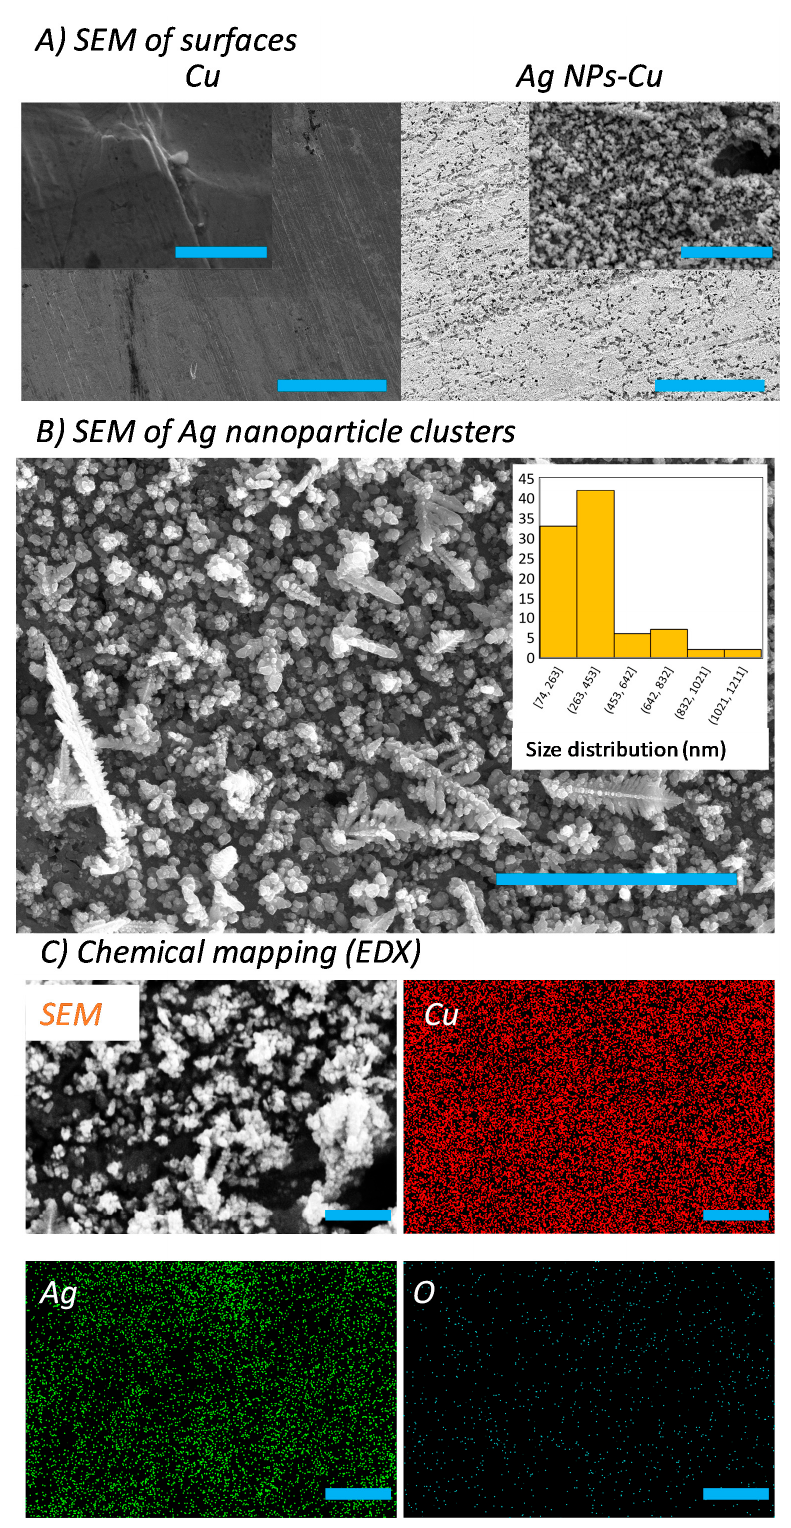
Figure 1. Surface characterization of pristine Cu and Ag nanoparticle coatings (Ag NPs-Cu). ( A ) SEM images showing the surface topography of pristine Cu (left) and Ag NPs-Cu (right) surfaces (Scale bar 20 µ m, inset 3 µ m). ( B ) High resolution SEM image showing Ag NPs cluster domains (scale bar 4 µ m). The inset shows the cluster size distribution. ( C ) EDX spectroscopy showing the distribution of Cu, Ag, and O elements across the Ag NPs-Cu surfaces (scale bar 1 µ